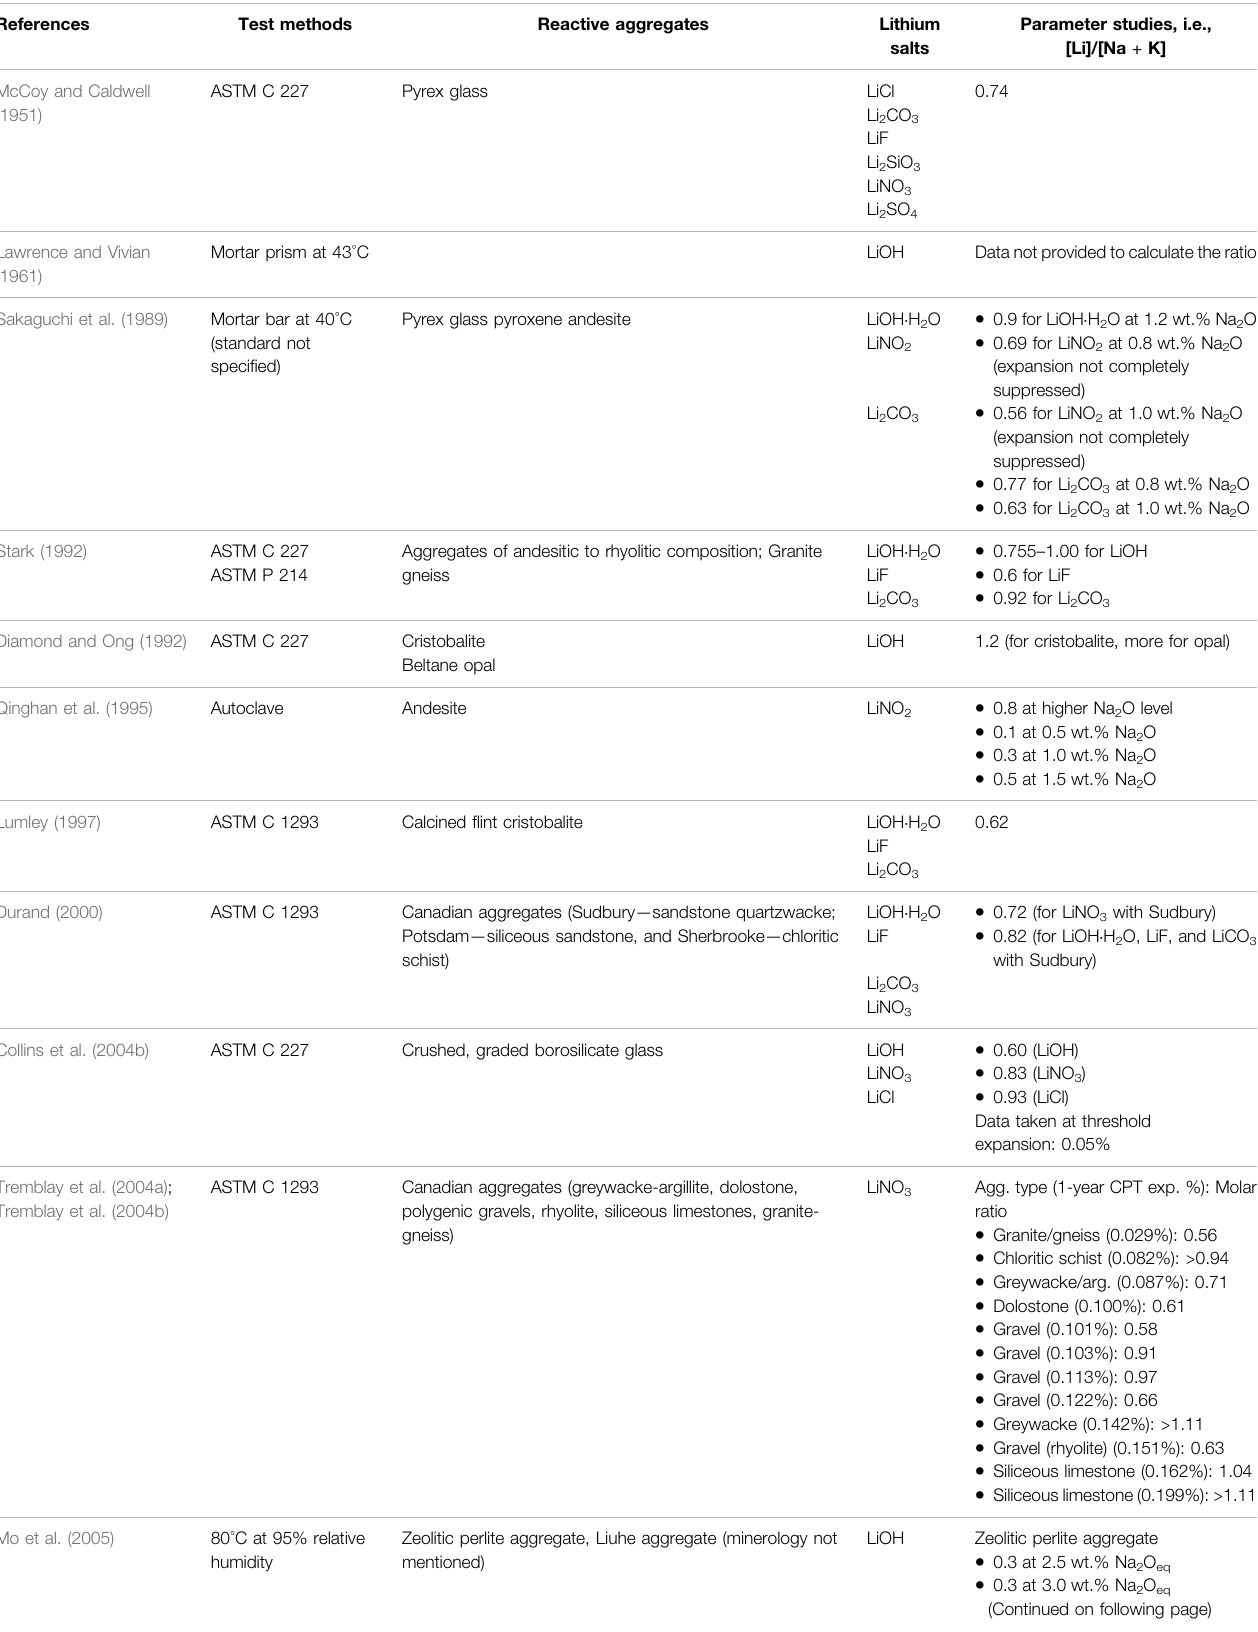
TABLE 1 | Summary of selected research fi ndings related to the lithium dosage ([Li]/[Na + K] molar ratio) needed to suppress ASR expansion and their test conditions. The table is adapted based on the version published in (Folliard et al.,